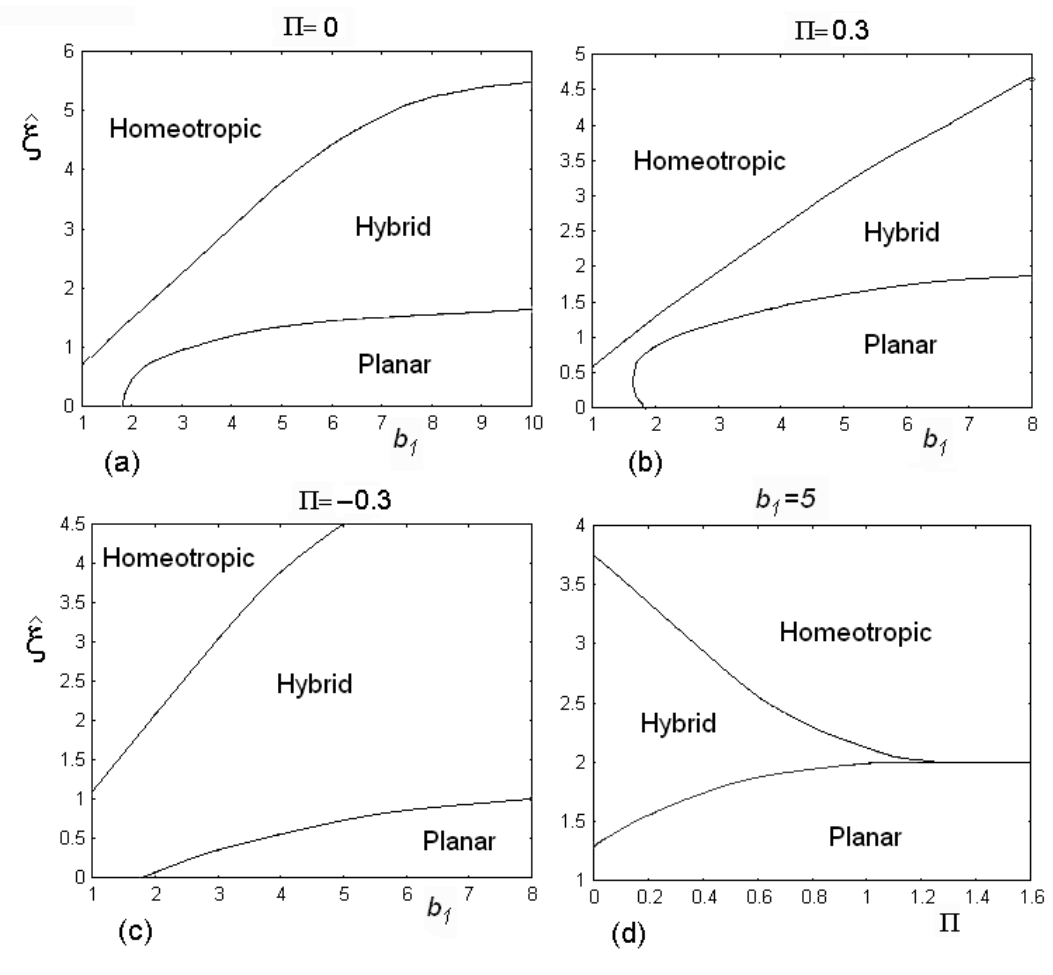
Figure 5. Phase diagrams of the HAN cell, for a fixed choice of the surface parameter b . We change the value of parameter 1 = b and find the value of the thresholds of the o 1 ) . There are three regions in the diagrams where planar, electric dimensionless field ξ homeotropic and hybrid alignments are allowed. The phase diagram is depending on the values of flexoelectric parameter Π . Diagram (d) shows the behaviour of a cell when the flexoelectric parameter Π changes. Note that the hybrid configuration disappears when flexoelectric parameter is higher than